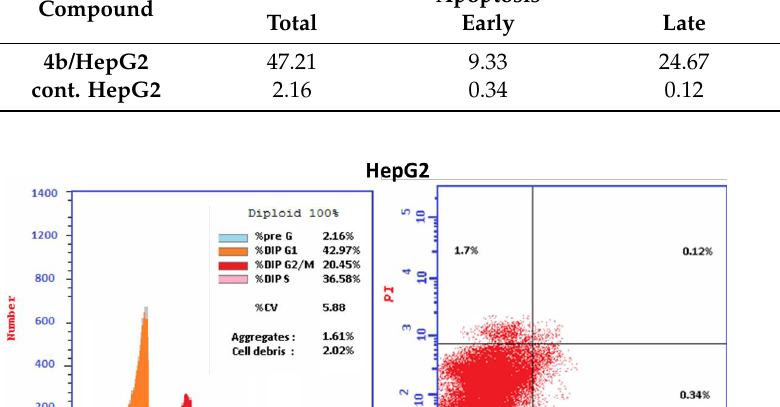
Table 5. Results of Apoptotic assay of compound 4b .